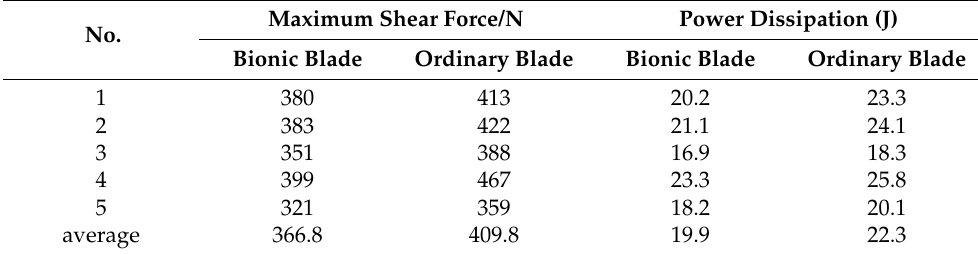
Figure 15. Comparison between the cutting effects of two blades. Table 8. Bench test results.